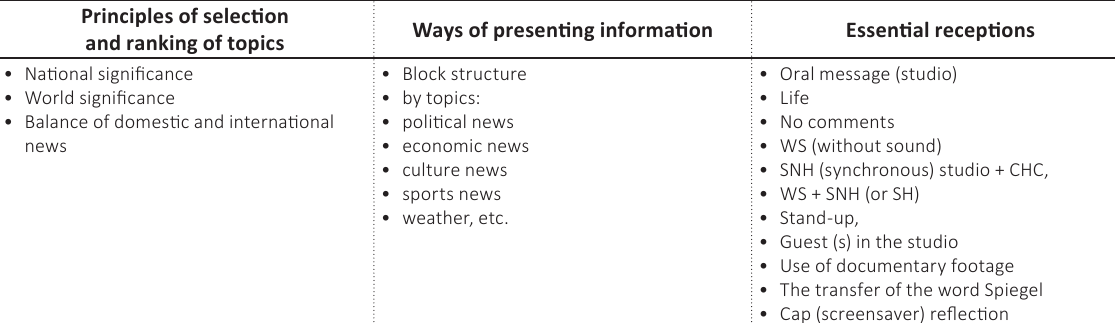
Table 3. Structural model of standard TV layout Principles of selection and ranking of topics